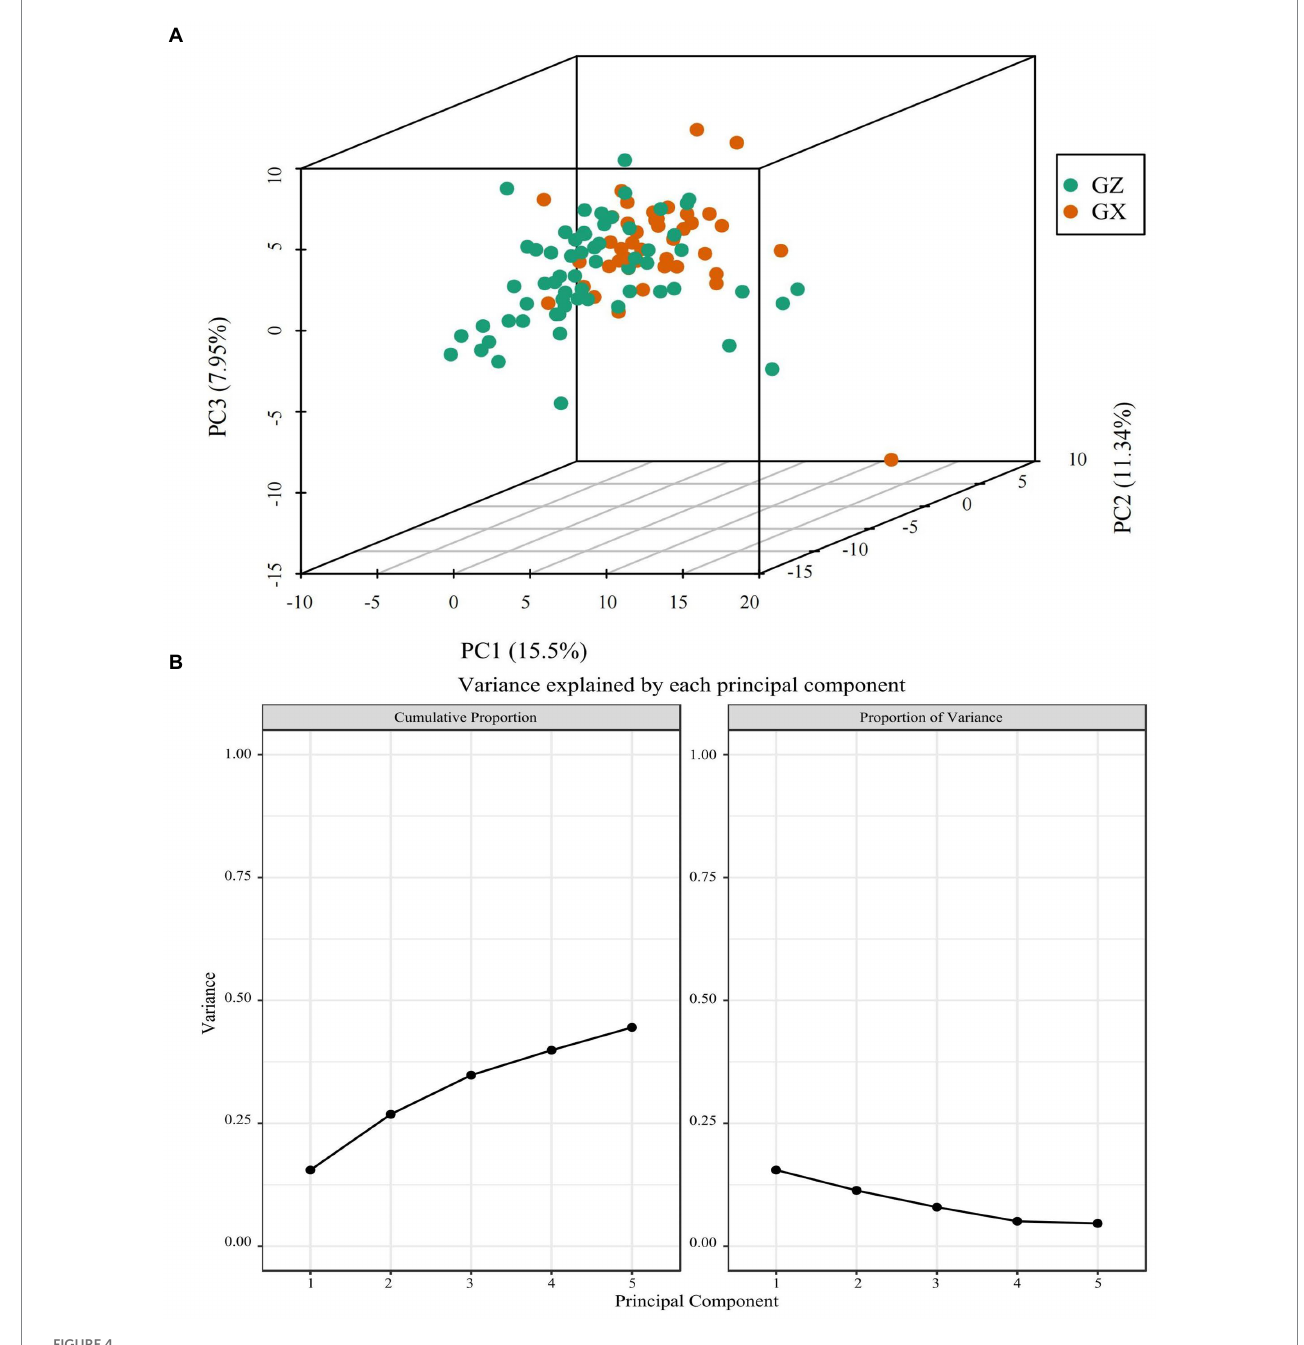
FIGURE 4 The three-dimensional (3D) PCA (A) and variation explained by each principal component (B)